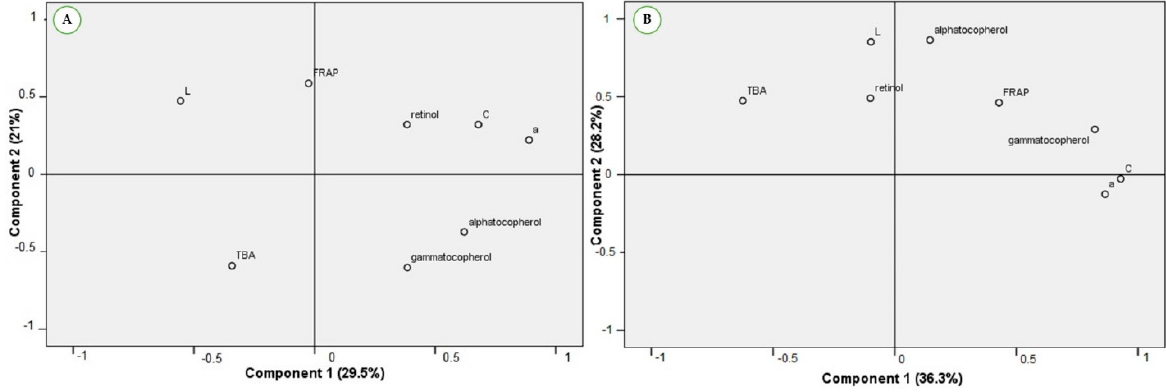
Figure 3. Principal component analysis (PCA) depicting the relationship between the oxidant/antioxidant status and the color parameters, at ( A ) R1 conditions (aerobic exposure for seven days) and at ( B ) R2 conditions (vacuum-packed storage for 25 days, plus aerobic exposure for three days).